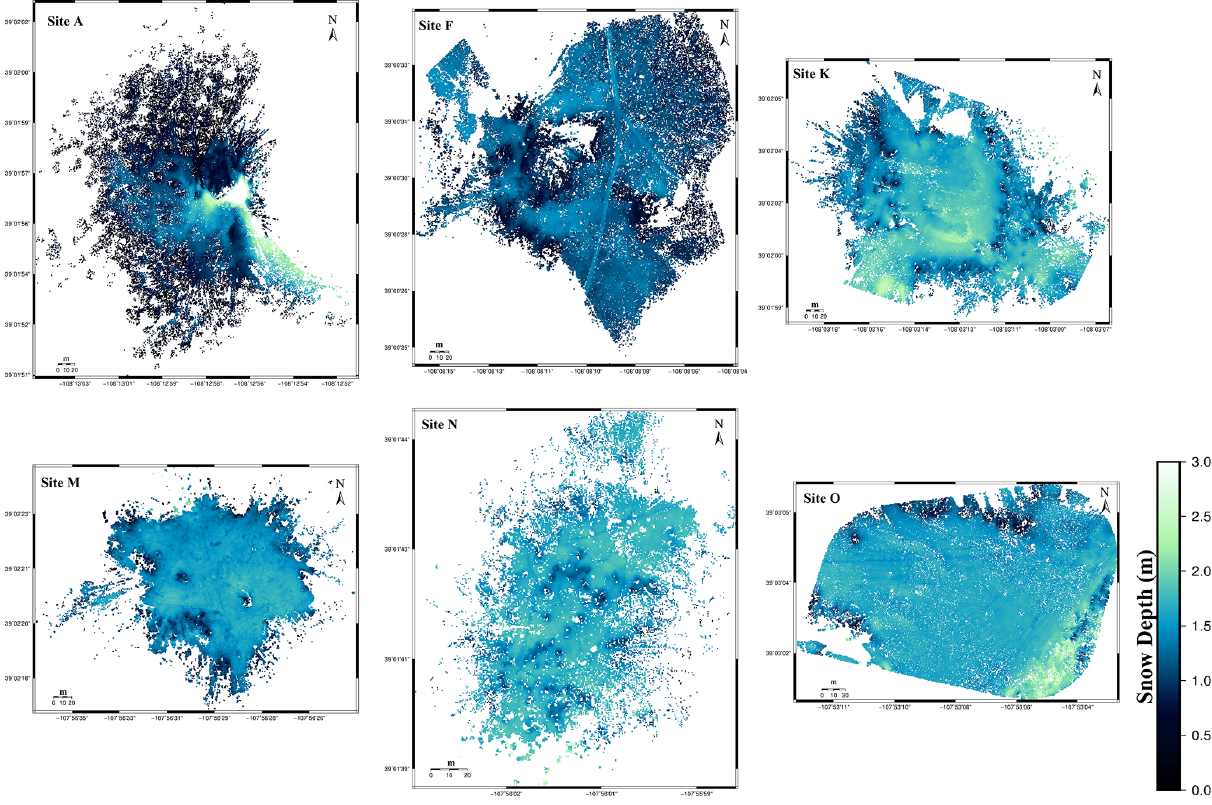
Figure 5. Snow depths at each site from TLS data. Table 2. The highest and second-highest coefficients and their associated p values for multiple linear regression between vegetation, topog- raphy and snow depth under individual trees. The p values > 0 . 001 are described as not